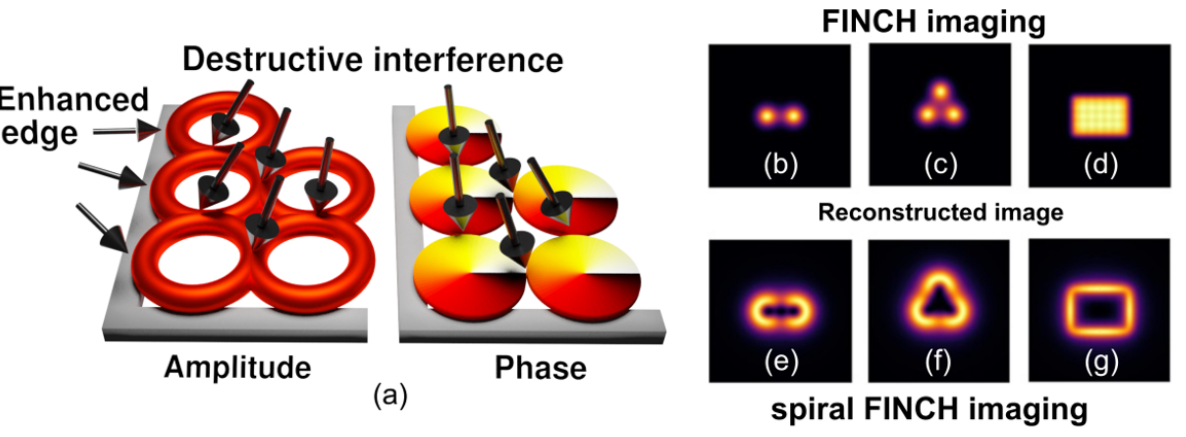
Figure 16. Destructive interference of vortex impulse responses ( a ), and demonstration of intensity images created for ( b ) and ( e ) two-point object, ( c , f ) three-point object, and ( d , g ) 7 × 5 array of point objects.